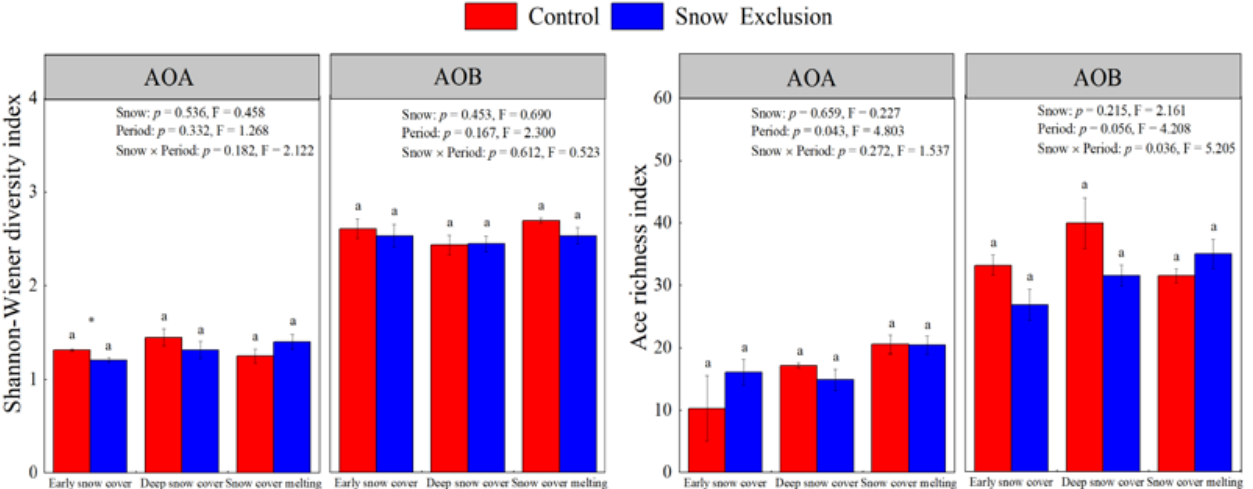
Figure 2. The Ace richness index and Shannon diversity index of soil AOA and AOB communities in the control and snow exclusion plots during the winter. Data shown are mean ± s.e. Different lowercase letters indicate significant differences between sampling periods under the same snow regime. p -Values for snow treatment (Snow), sampling period (Period), and their interactions from repeated measures ANOVA are inserted in the figure.